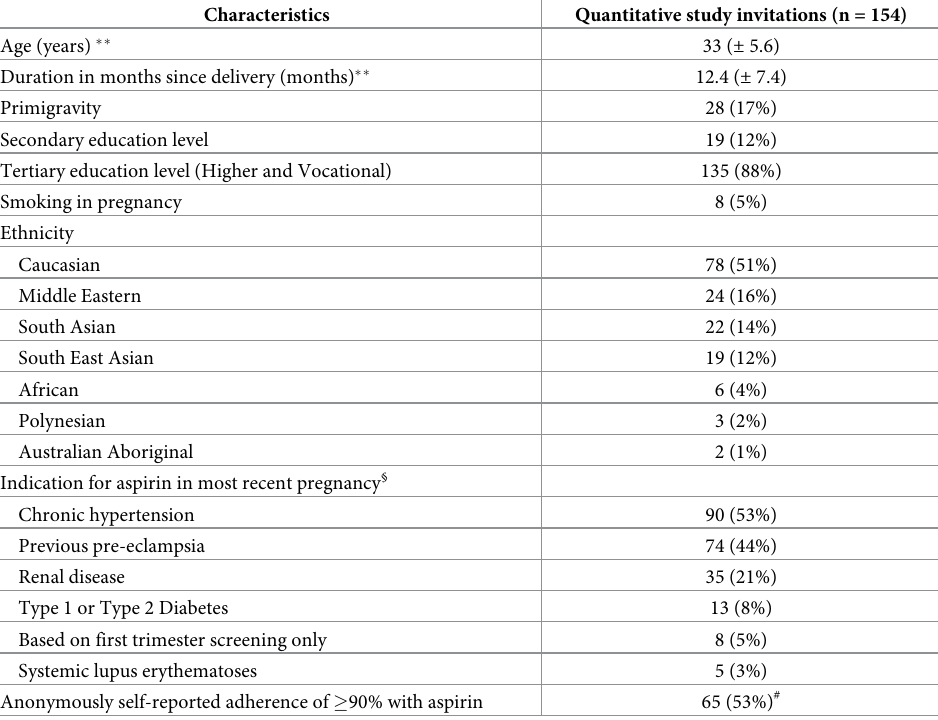
Table 1. Characteristics of participants invited to participate in quantitative study ( �